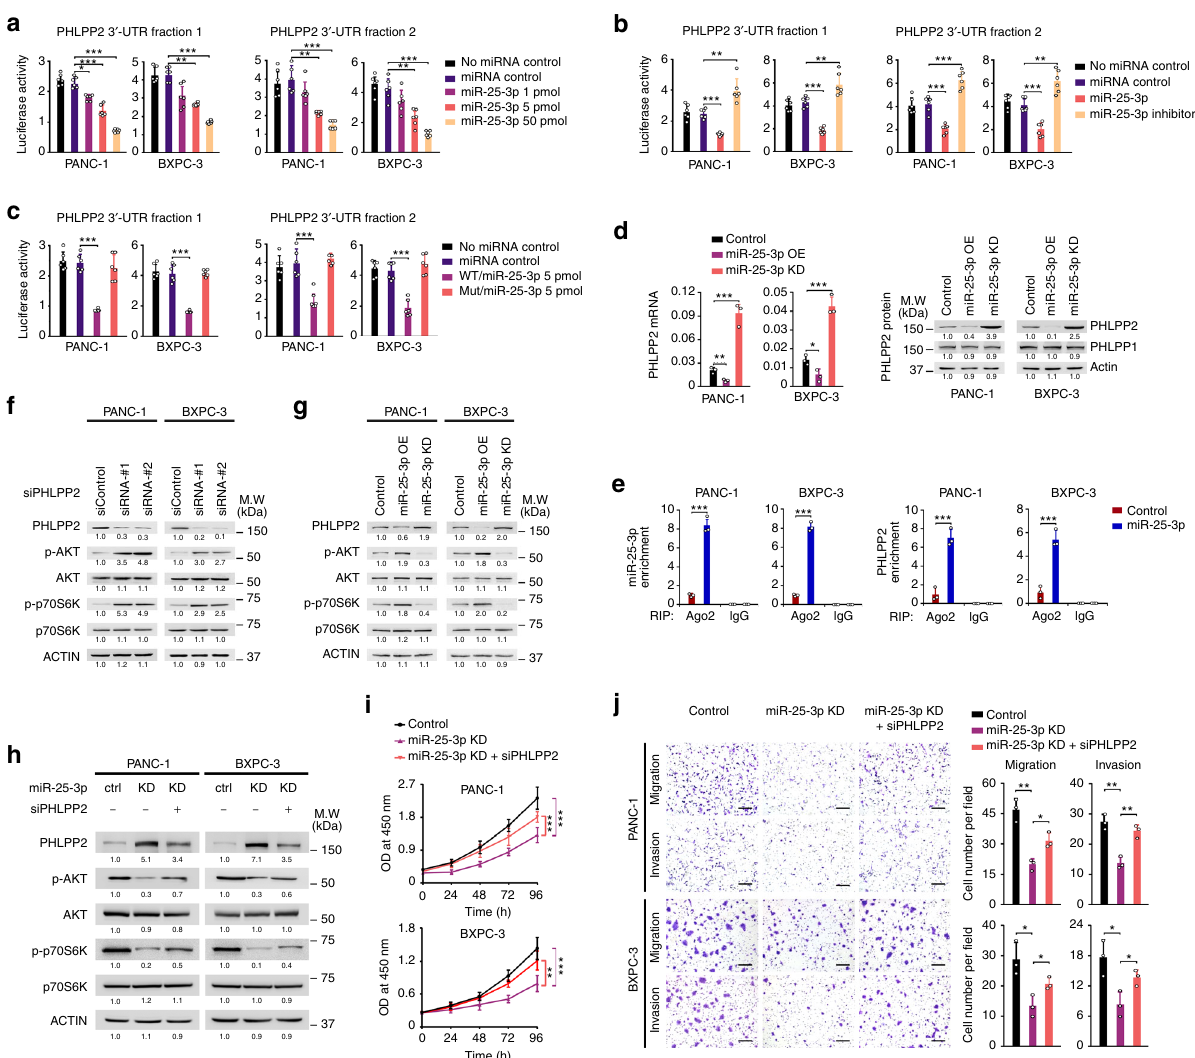
Fig. 6 MiR-25-3p targets PHLPP2 and evokes oncogenic AKT-p70S6K signaling. a Relative reporter gene activity of psiCHECK2 vector bearing PHLPP2 3 ′ - UTR fraction 1 (left panel) or fraction 2 (right panel) in PDAC cells co-transfected with increasing amounts (1, 5, and 10 pmol) of miR-25-3p mimic. b Relative reporter gene activity of constructs bearing PHLPP2 3 ′ -UTR fraction 1 (left panel) or fraction 2 (right panel) in PDAC cells co-transfected with 5 pmol of miR-25-3p mimic or its inhibitor. c Reporter gene activity of psiCHECK2 vector bearing PHLPP2 3 ′ -UTR fraction 1 (left panel) or fraction 2 (right panel) or their mutant counterparts in PDAC cells in the presence of 5 pmol miR-25-3p mimic. Results in ( a ), ( b ), and ( c ) represent means± S.D. from three experiments and each had six replicates. d Stable overexpression or knockdown of miR-25-3p on the levels of PHLPP2 RNA (left panel) and protein (right panel). Results of mRNA represent means ± S.D. from three independent experiments. e RNA immunoprecipitation assays show signi fi cantly increased association with Ago2 of both miR-25-3p (left panel) and PHLPP2 mRNA (right panel) in PDAC cells overexpressing miR-25-3p. Results represent means± S.D. from three independent experiments. f MiR-25-3p evokes AKT-p70S6K signaling via PHLPP2. Knockdown of PHLPP2 substantially enhanced AKT and p70S6K phosphorylation activation in PDAC cells. g Overexpression or knockdown of miR-25-3p had substantial effects on PHLPP2 expression and phosphorylation of its downstream signaling modules. h Knockdown of PHLPP2 expression substantially rescued the activation of AKT and p70S6K suppressed by miR-25-3p knockdown in PDAC cells. Ctrl control, KD knockdown. i Knockdown of PHLPP2 expression signi fi cantly reversed the effects of miR-25-3p knockdown on PDAC cell proliferation. Results represent mean ± S.D. from three independent experiments. j Knockdown of PHLPP2 expression signi fi cantly reversed the effects of miR-25-3p knockdown on PDAC cell migration and invasion. Left panel shows representative images of transwell assays and right panel shows quantitative statistics. Results are mean ± S.D. from three random fi elds. All statistic analyses in this fi gure are Student t test. * P < 0.05, ** P < 0.01, and *** P < 0.001 compared with the corresponding